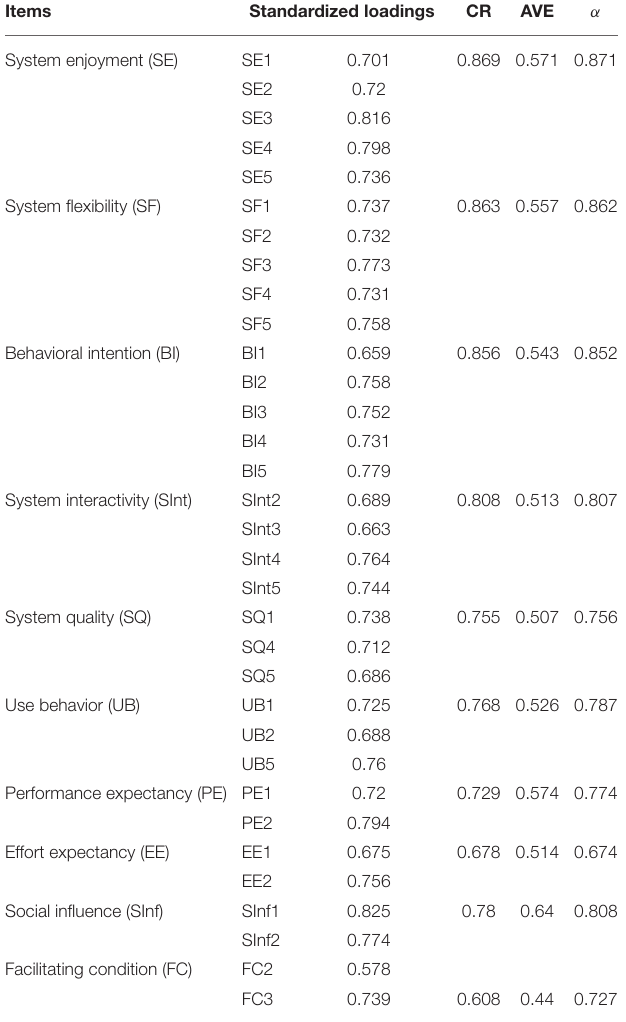
TABLE 3 | CFA results of the final measurement model.